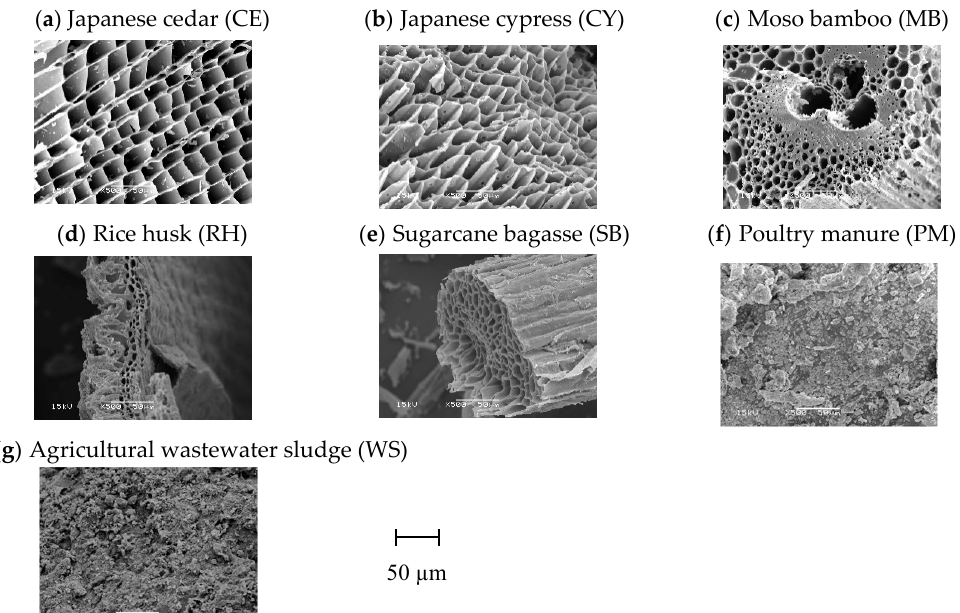
Figure 2. SEM micrographs of biochar samples formed at 600 °C. ( a ) Japanese cedar (CE); ( b ) Japanese cypress (CY); ( c ) moso bamboo (MB); ( d ) rice husk (RH); ( e ) sugarcane bagasse (SB); ( f ) poultry manure (PM); ( g ) agricultural wastewater sludge (WS).